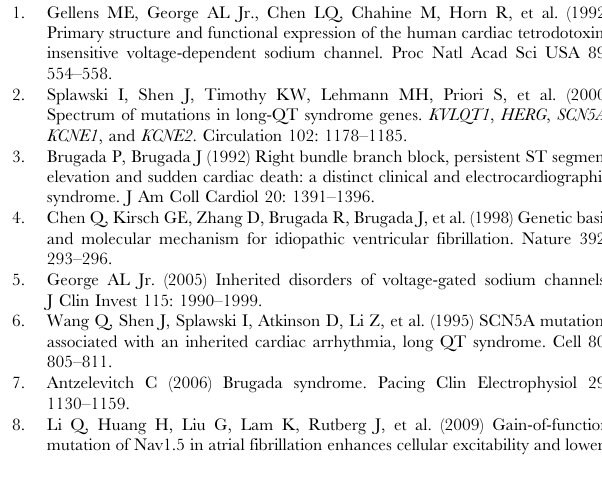
Figure S5 Effect of alanine, glutamine, lysine and cysteine substitution. The arginine 219 was substituted with expressing mutant channels were superfused with Na + -free NMDG solution at different pH o . Proton currents were measured every 2 seconds, using a hyperpolarizing pulse of 2 140 mV from a holding potential of 2 80 mV, as indicated in the inset. No proton currents could be seen in the presence of all mutant channels except for the cysteine mutant, where a slight inward deflection of the current at extreme acidic pH o value (5.20) (d) was observed, but we did not study this effect in greater detail. Similar results were obtained in two separate batches of oocytes.